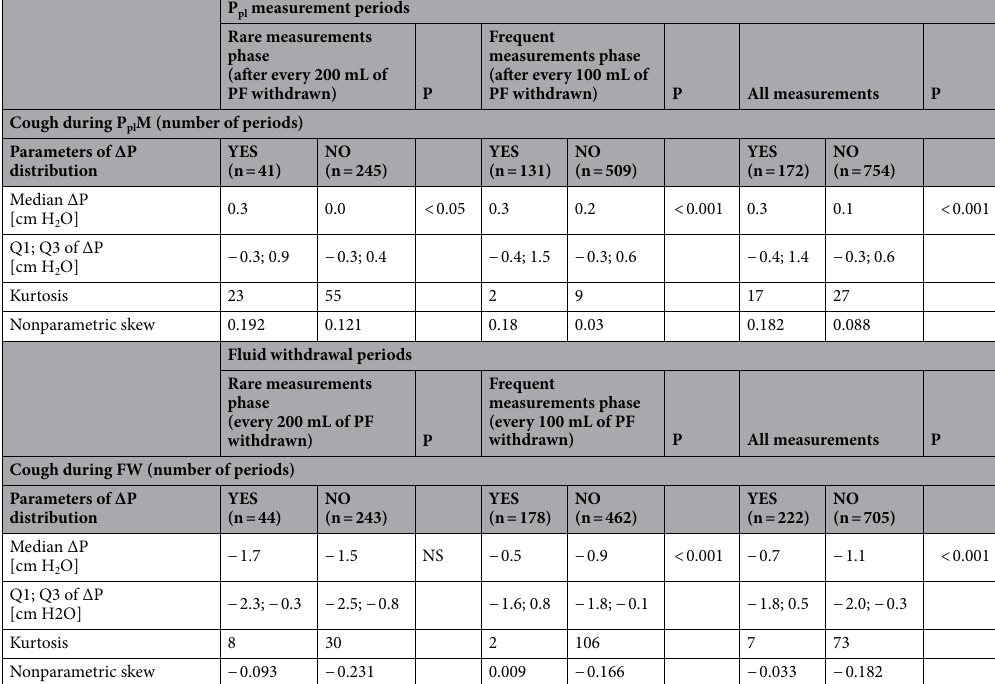
Table 2. P pl changes during measurement and fluid withdrawal periods with and without cough. PF—pleural fluid; n—number of periods with/without cough; ∆P—the difference between the end-expiratory P pl values at the end and beginning of a period; Q1 and Q3—the first and third quartile, respectively; The two sample Kolmogorov–Smirnov test was used to assess statistical significance of differences between the ΔP distributions in periods with and without cough.